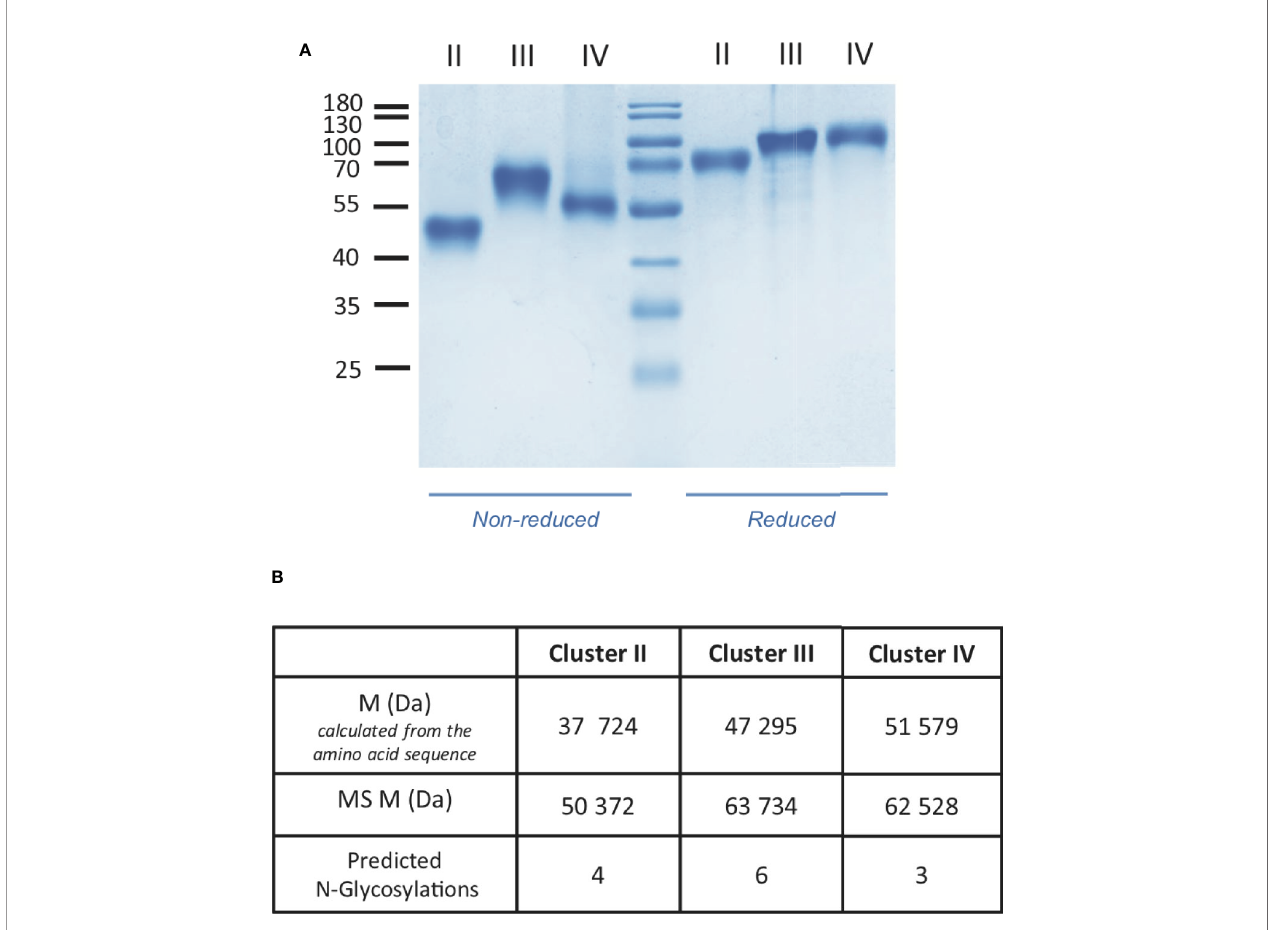
FIGURE 2 | Characterization of LRP1 clusters. (A) SDS-PAGE analysis of LRP1 clusters. Clusters II, III and IV in non-reducing (left) and reducing conditions (right), molecular weight markers are indicated in kDa. (B) , MALDI mass spectrometry analysis of LRP1 clusters. M, molecular weight; MS, Mass